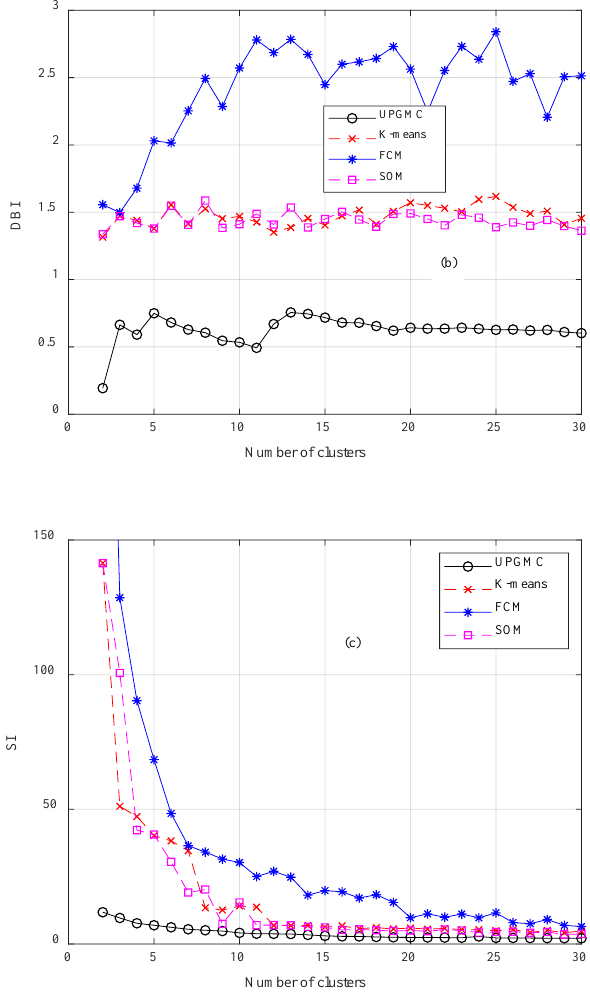
Figure 8. Algorithms comparison using: ( a ) J; ( b ) DBI; ( c ) SI indicators. The patterns dimension is D = 24.